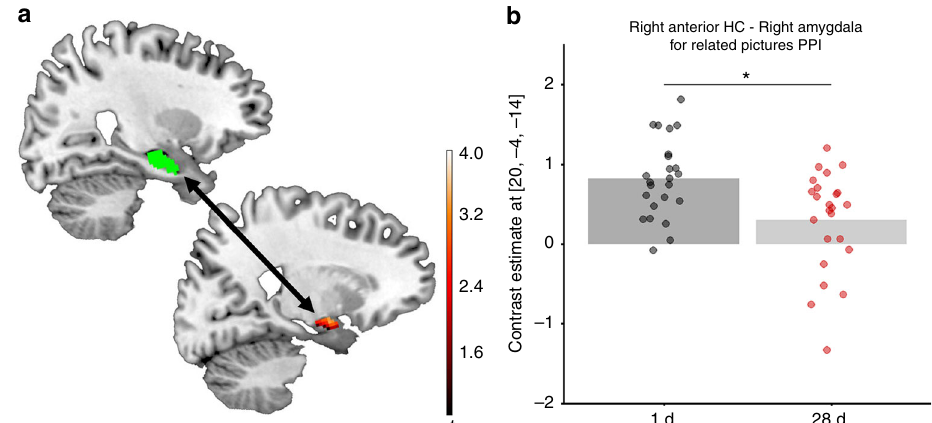
Fig. 3 Connectivity with amygdala. a Visualization of the connectivity between right aHC and right amygdala. Green represents the anatomical right aHC mask; red represents activation in the right amygdala for the contrast 1 d > 28 d of PPI interactions for related pictures with the right aHC as seed. Visualizations are superimposed on sagittal sections of a T1-weighted template image. b Parameter estimates in the peak voxel in the right amygdala. The right aHC showed a reduced connectivity to the right amygdala in the 28 d group compared to the 1 d group for related pictures (SVC peak level: x = 20, y = − 4, z = − 14, t = 3.59, p (FWE) = 0.0156, k = 15), but not for old or novel pictures. Note that neither using the left aHC nor the pHC (left or right) as seed regions, nor looking at other ROIs resulted in signi fi cant group differences in connectivity. See also Supplementary Table 3. * p <